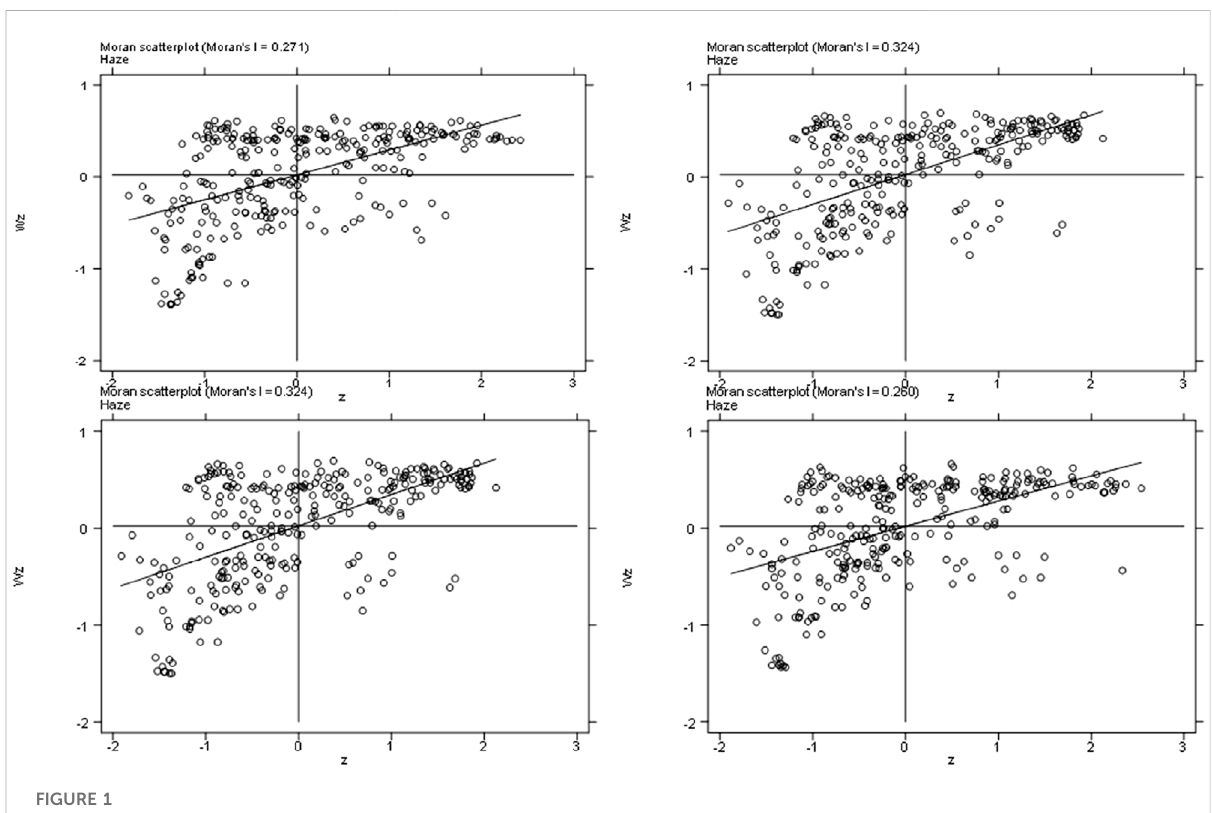
FIGURE 1 Moran ’ s I index scatter